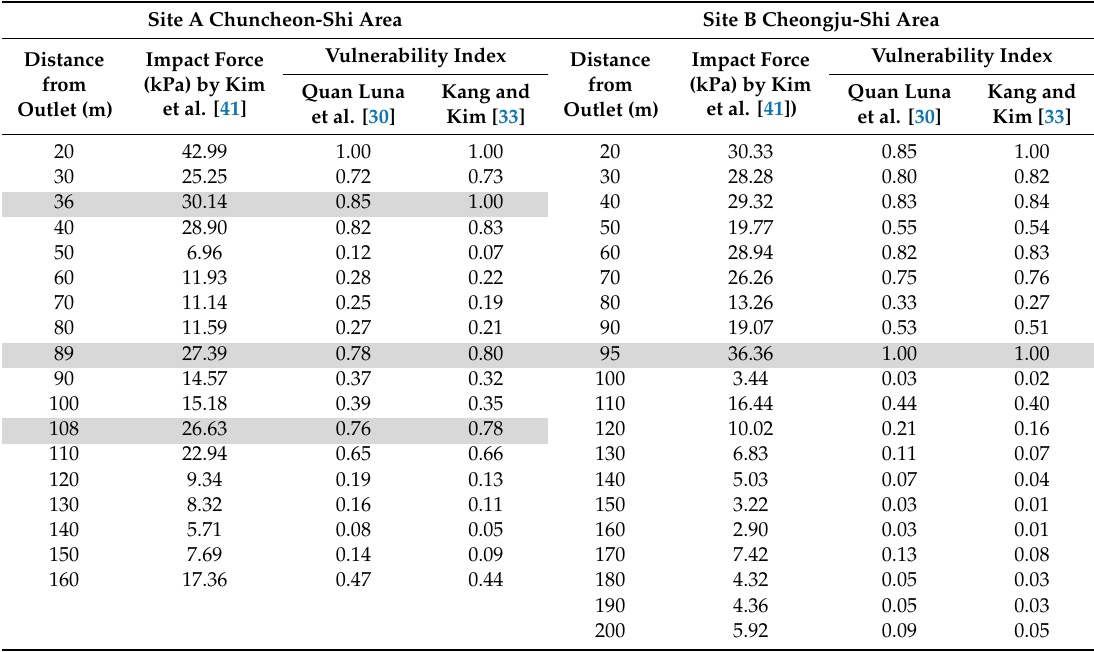
Table 3. Calculation of vulnerability based on impact